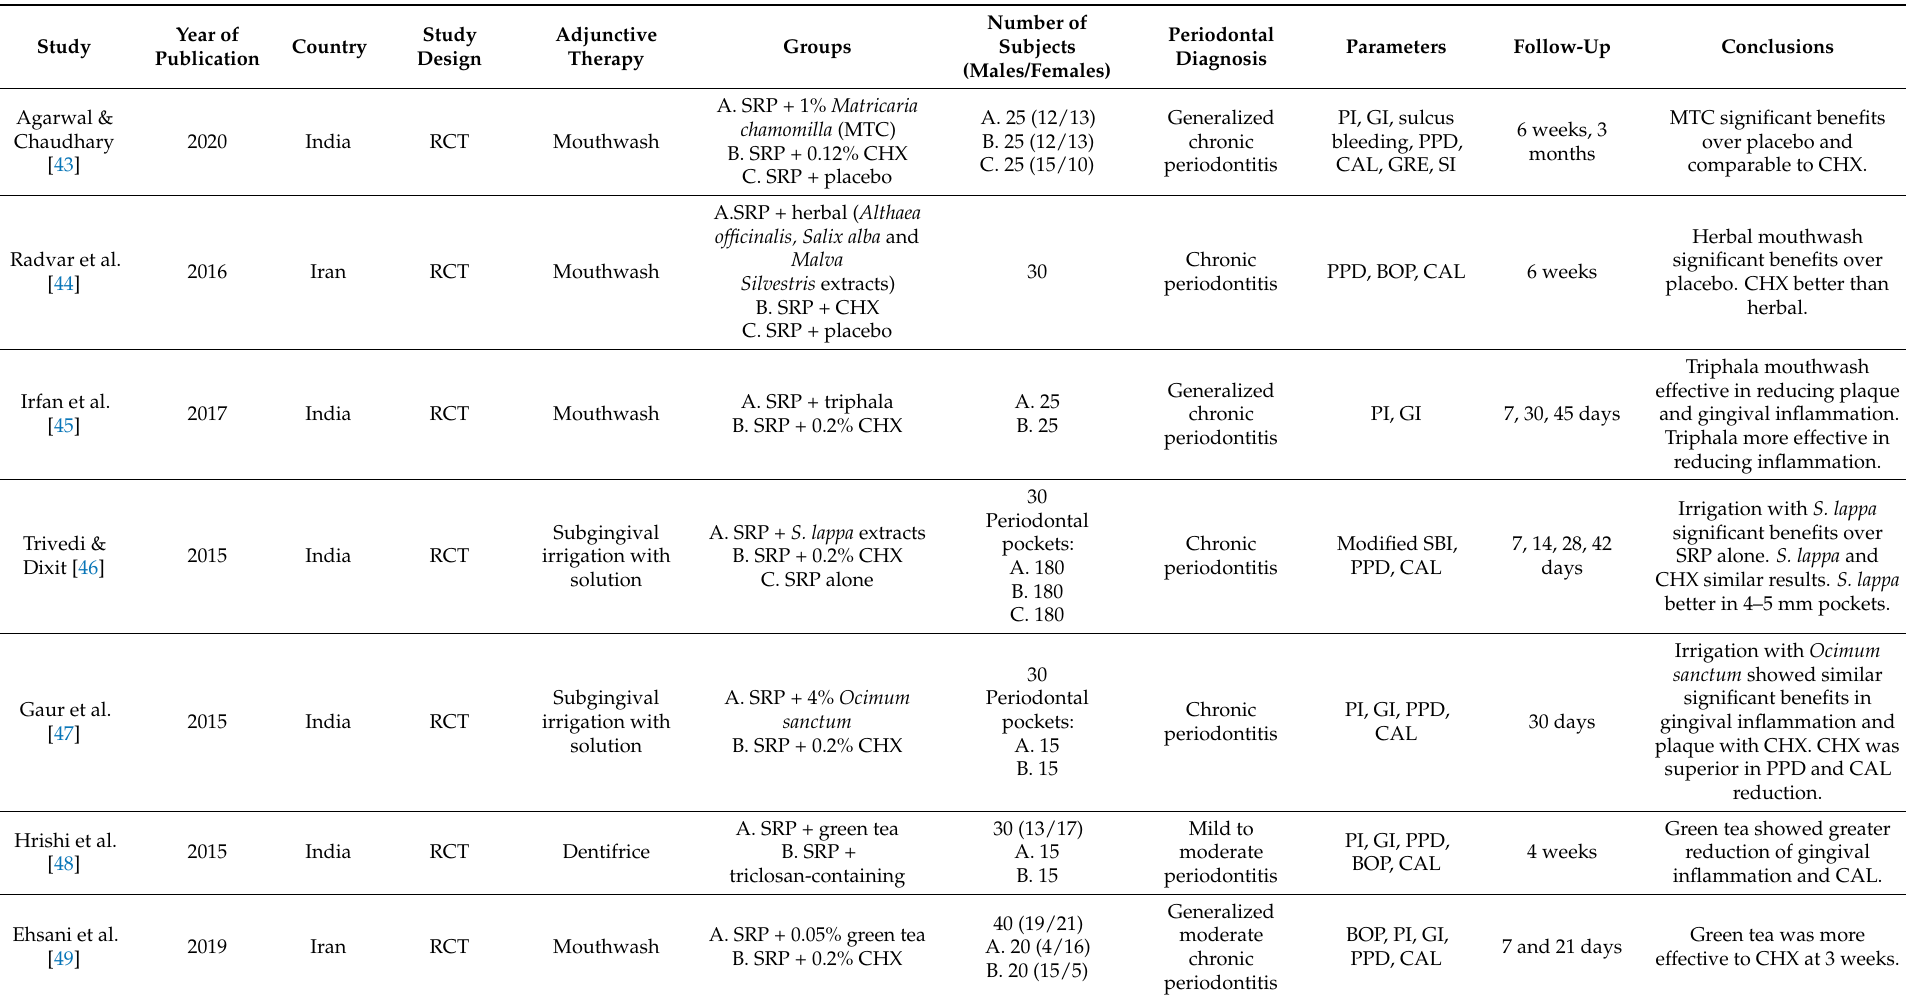
Table 1. The characteristics of the included